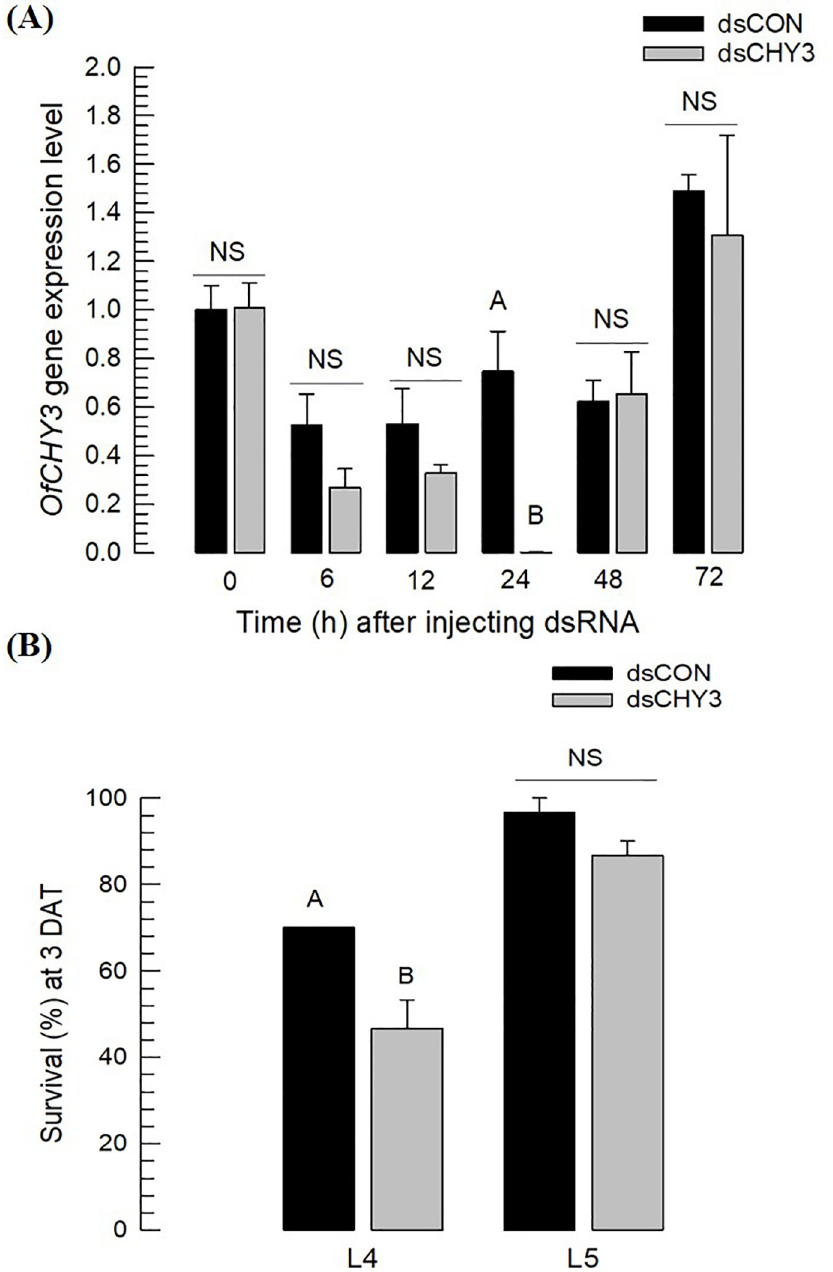
Fig 6. RNAi of Of-CHY3 by injecting its dsRNA to L5 larvae of O . furnacalis . Each larva was injected 2 μ g of dsRNA. As control, the same amount of dsRNA (‘dsCON’) specific to EGFP was injected. (A) Change in expression levels of OfCHY3 after dsRNA injection to L5 larvae. RT-qPCR used RNA samples collected from whole body. (B) Effect of dsRNA injection on survival of O . furnacalis larvae at different stages. Survival rate was determined at three days after treatment (‘3 DAT’). Each treatment was replicated three times. Ten larvae were used in each replication. Different letters above standard error bars indicate significant difference among means at Type I error = 0.05 (Tukey